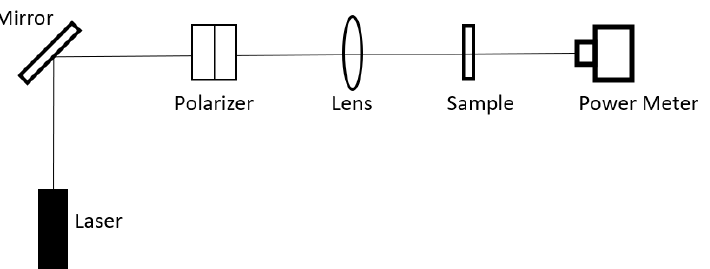
Figure 7. Schematic of the experimental set-up used for measuring the transmission of a 1.5 mm thick PMN-PT ceramic slab at three different wavelengths (532 nm, 632.8 nm, and 1550 nm). Those three measurements were used to verify the three points of the transmission spectrum calculated by Equation (17) using the refractive indices defined by the FTIR method.